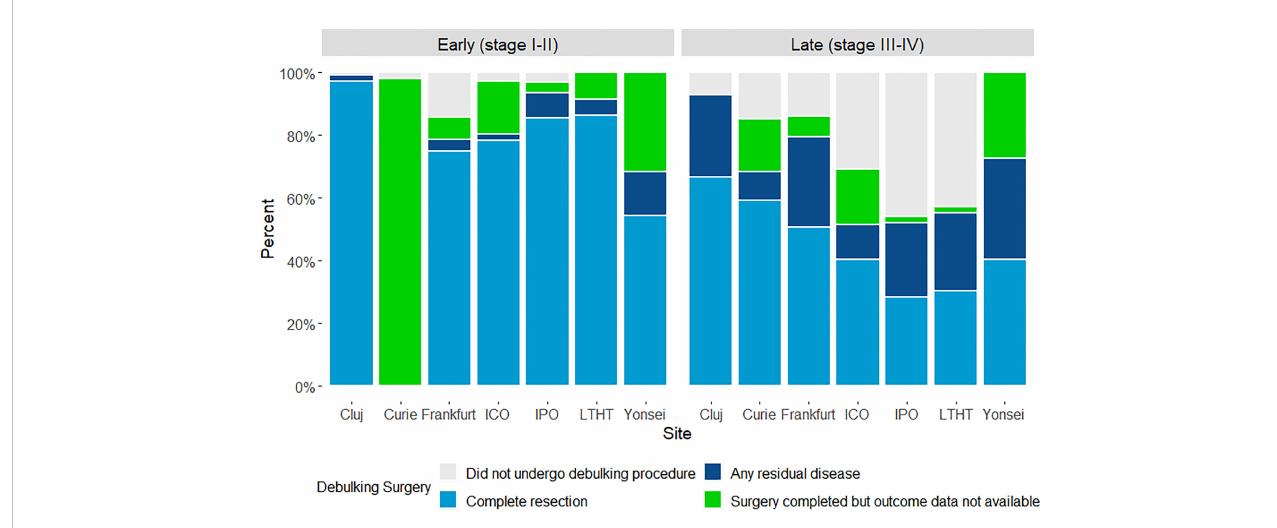
FIGURE 3 Outcome achieved following primary surgical debulking surgery, by study site and FIGO disease stage.